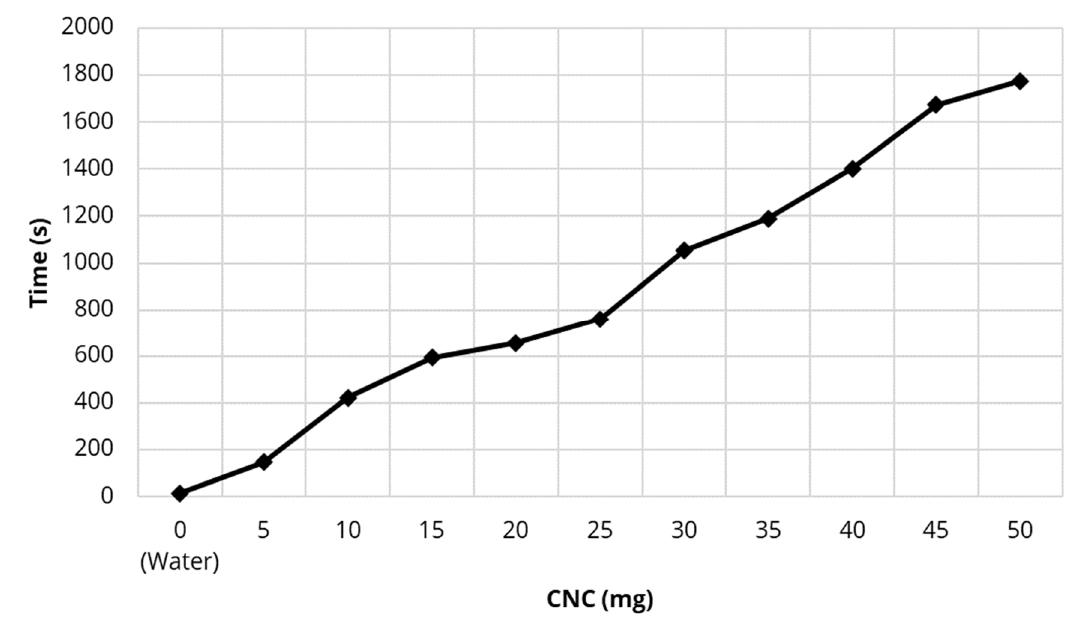
Figure 3. Effect of filtering increasing amounts of nanocrystalline cellulose (CNC) onto the Millipore small-scale filter on the time for the suspension to filter.